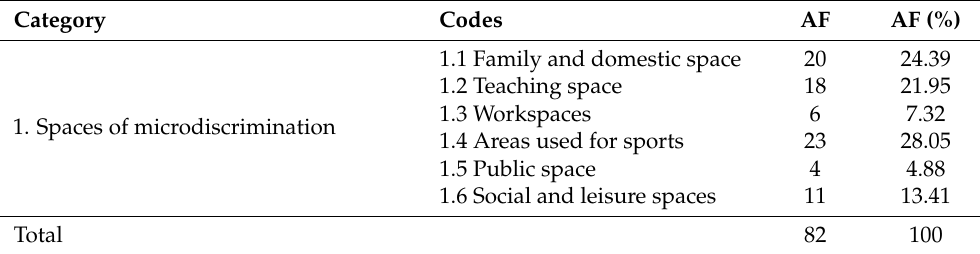
Table 1. Frequencies emerging from the narratives coded under Category